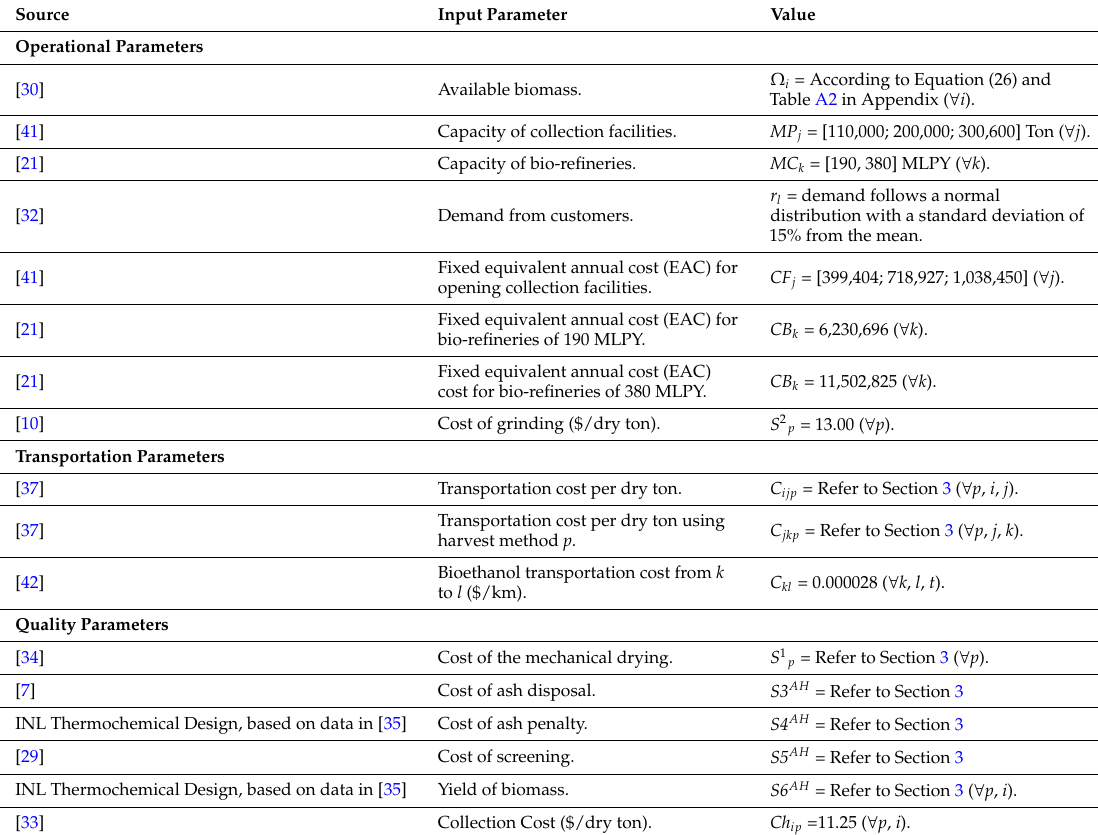
Table A1 summarizes the parameters used in the case study and their sources. Table A1. List of input parameters for the BioSC-COQ